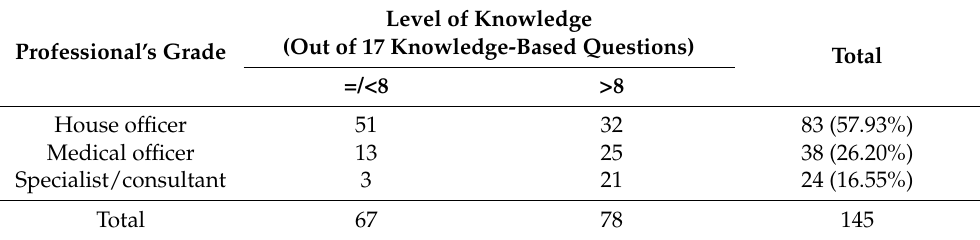
Table 5. Number of respondents who achieved a satisfactory score according to professional’s grade.